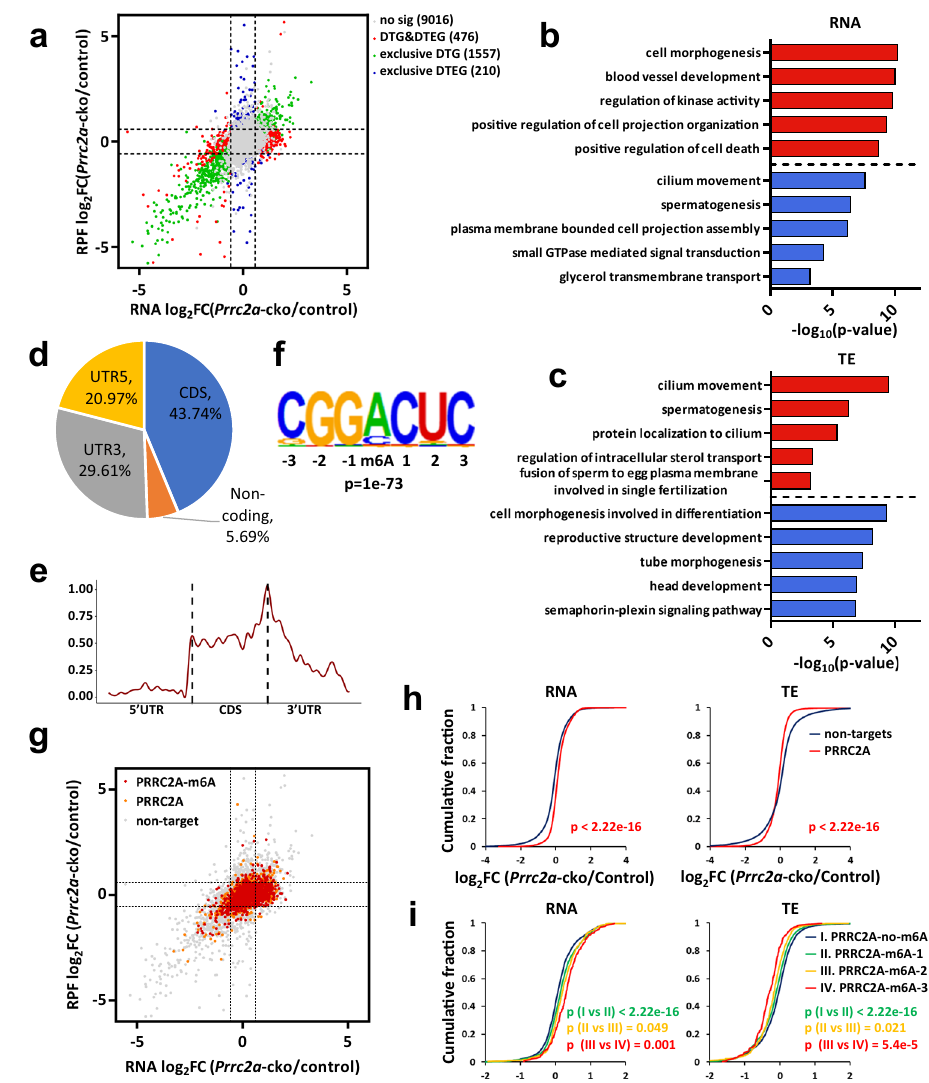
Fig. 5 | PRRC2A decreases the mRNA abundance and improves the translation ef fi ciency of its targets. a Scatter plots of Ribo-seq vs RNA-seq in control and PRRC2A-null spermatocytes. Genes were classi fi ed according to their regulation with the parameters indicated criteria. Gray dots (no sig) indicate genes with no signi fi cant change. Green dots (exclusive DTG) indicate genes with signi fi cant changes in RNA abundance (fold change (FC)>1.5, p -adjusted<0.05) and with no change in translation ef fi ciency. Blue dots (exclusive DTEG) indicate genes with signi fi cant changes (FC>1.5, p -value<0.05) in translation ef fi ciency and with no change in RNA abundance. Red dots (DTG&DTEG) indicate genes with signi fi cant changes in RNA abundance and translation ef fi ciency. b , c Top GO terms in bio- logicalprocesscategoriesofdownandupregulatedDTGs( b )andDTEGs( c ). d The pie chart shows the distribution region of PRRC2A-binding peaks on transcripts in one of two repeats. e Distribution of PRRC2A-binding peaksalong with transcripts.